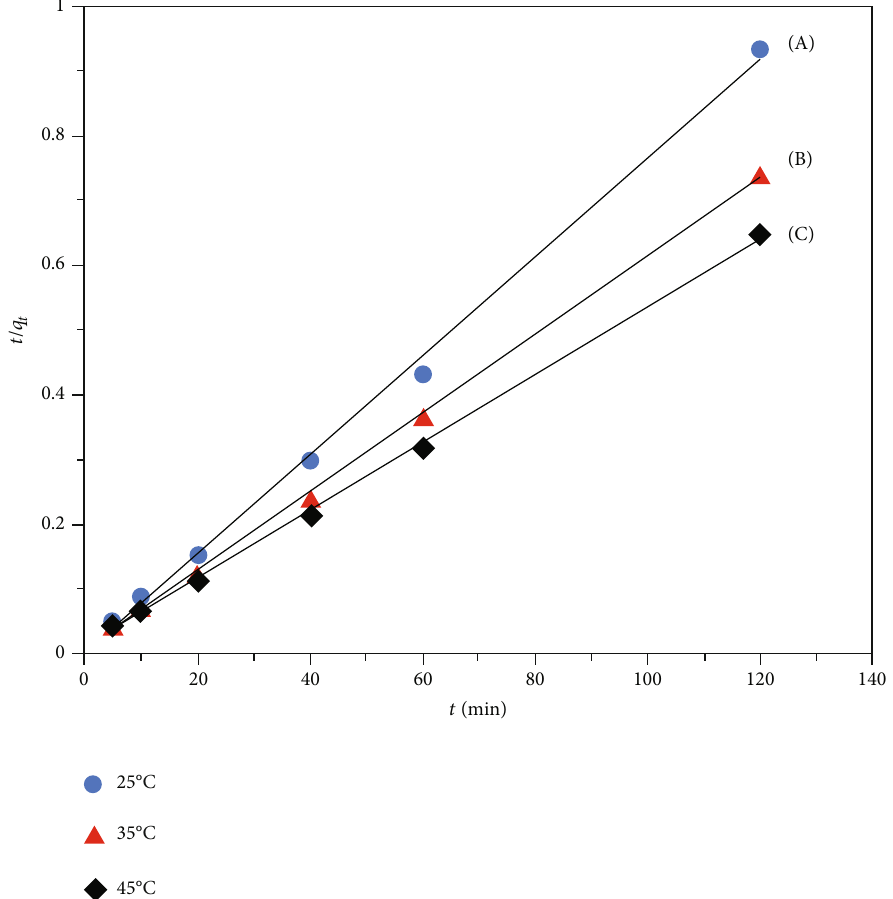
Figure 11: Pseudosecond-order kinetic curves of uranium adsorption on CuFe (B) 35 ° C, and (C) 45 ° C, respectively.